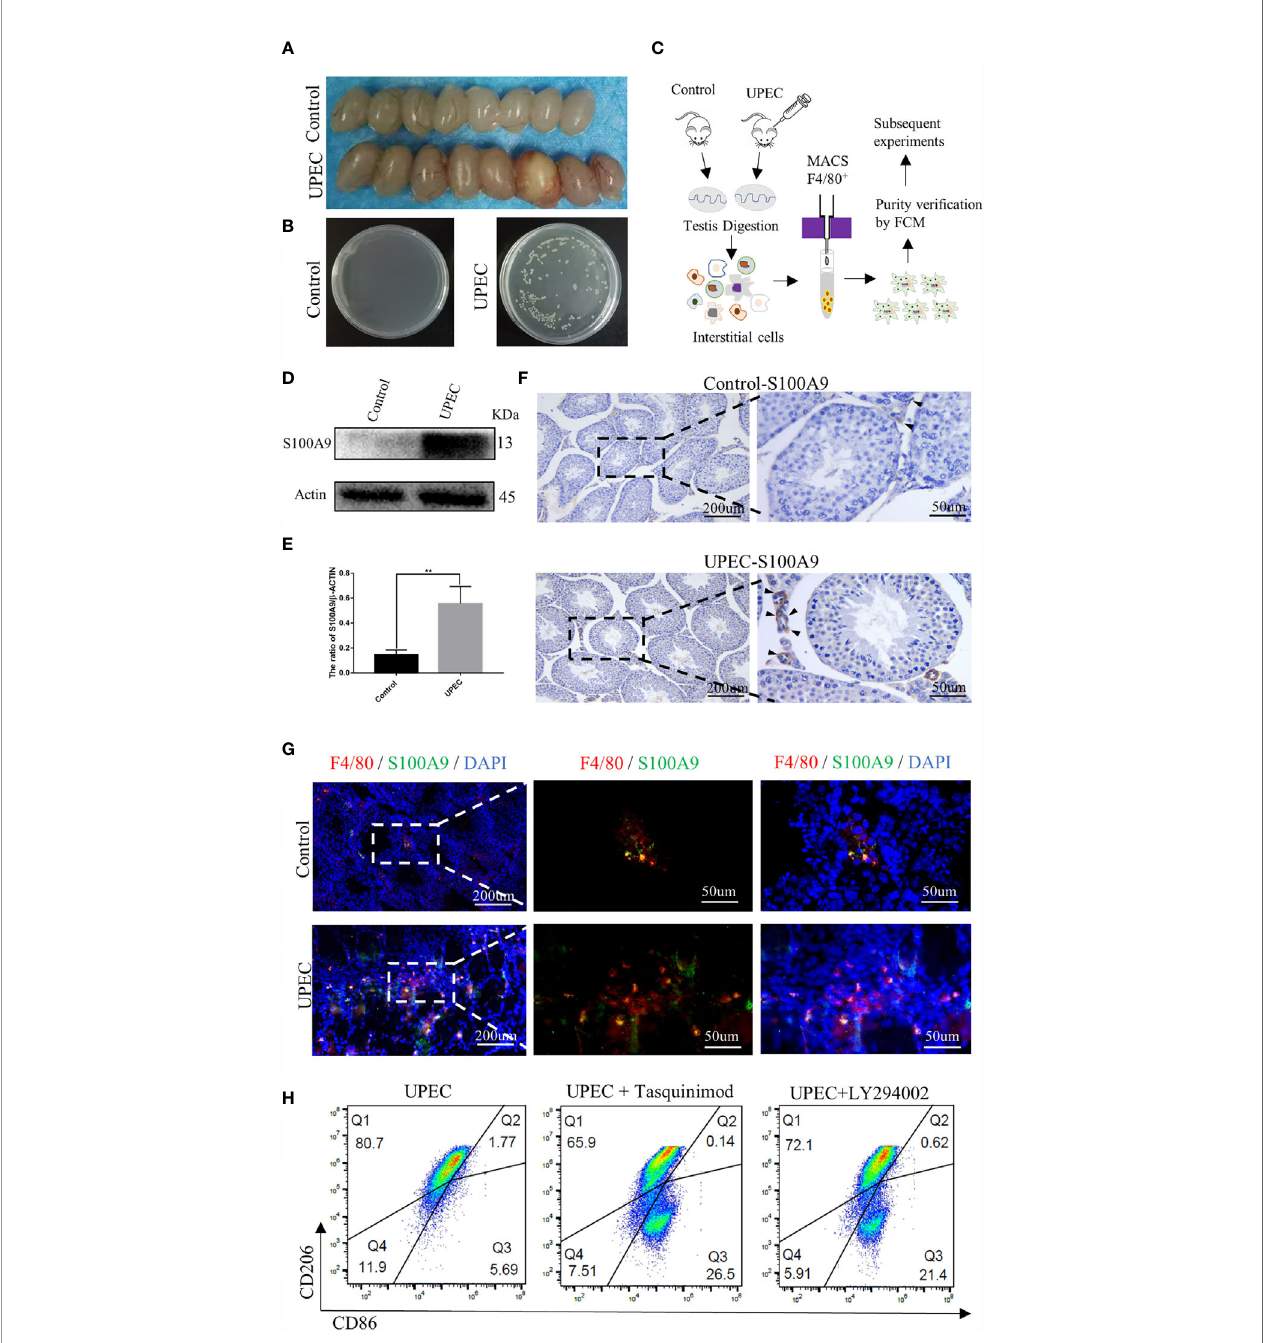
FIGURE 5 | S100A9 expression increased in TMs and treatment with tasquinimod or LY294002 attenuated the ratio of M2-TMs following UPEC-induced orchitis. (A) Comparison of testis between the control and UPEC infection groups (8week, n=4/group). (B) The growth of the colonies after homogenization and plating of testis tissues in the control and UPEC groups (n=4/group). (C) Flow chart of preparation for TMs, testes from control and UPEC group were digested and interstitial cells were incubated with F4/80 magnetic beads (8week, n=4/group). TMs were obtained by magnetic cell sorting (MACS), and the purity was veri fi ed by fl ow cytometry for subsequent experiment. (D, E) Western blot analysis results and quanti fi cation data of S100A9 expression in TMs of control and UPEC group (8week, n =4/group). Data represent the mean ± standard error. **P < 0.01. (F) Immunohistochemistry staining result of S100A9 in the control and UPEC group testis (8week) at the 7th day after infection. Black arrows showed the expression of S100A9 (scale bar: 200, 50 m m). (G) Double immuno fl uorescence staining of S100A9 and mouse macrophage marker (F4/80) in the testis (8week) of control and UPEC group (scale bar: 200, 50 m m). (H) Flowcytometric analysis of total TMs (8week, n =2/ group) was marked as CD45 + F4/80 + . Percentage of M2 F in testis decreased with the treatment of S100A9 inhibitor (tasquinimod) or PI3K inhibitor (LY294002), compared with the UPEC